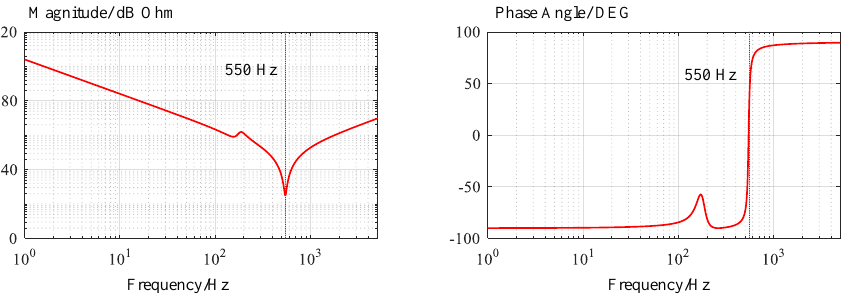
Figure 11. Resonant filter impedance Bode diagrams.